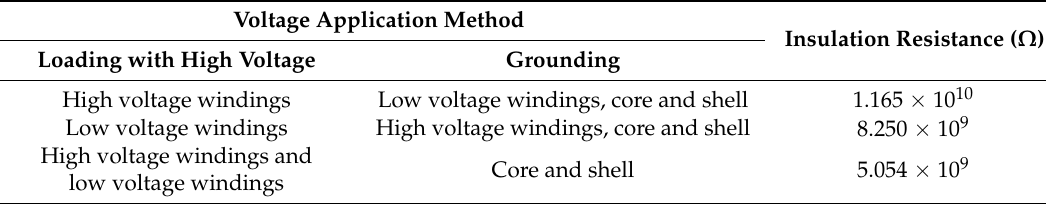
Table 3. Insulation resistance values.